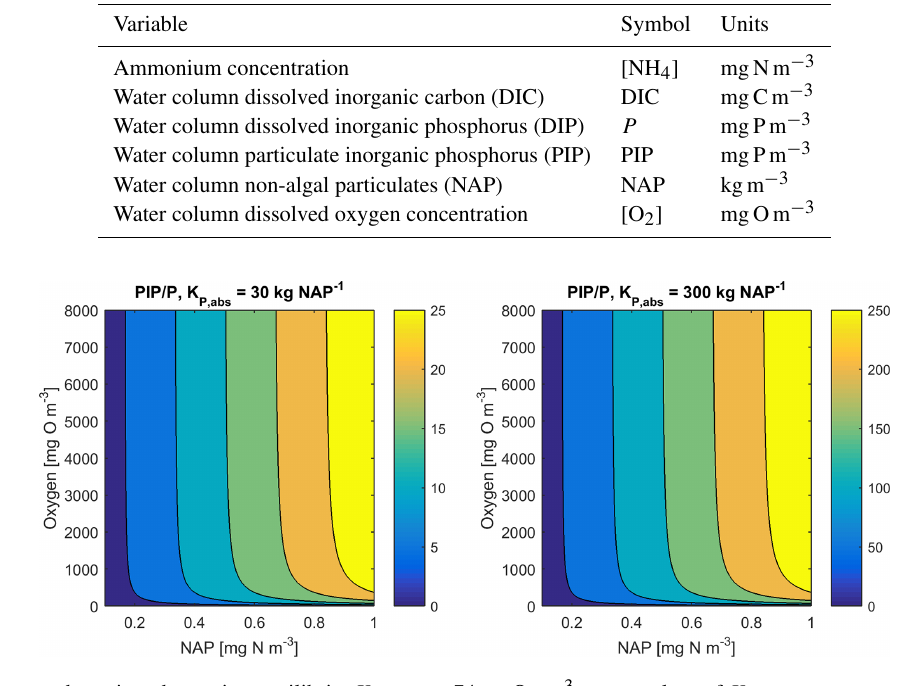
Figure 12. Phosphorus adsorption–desorption equilibria, K O